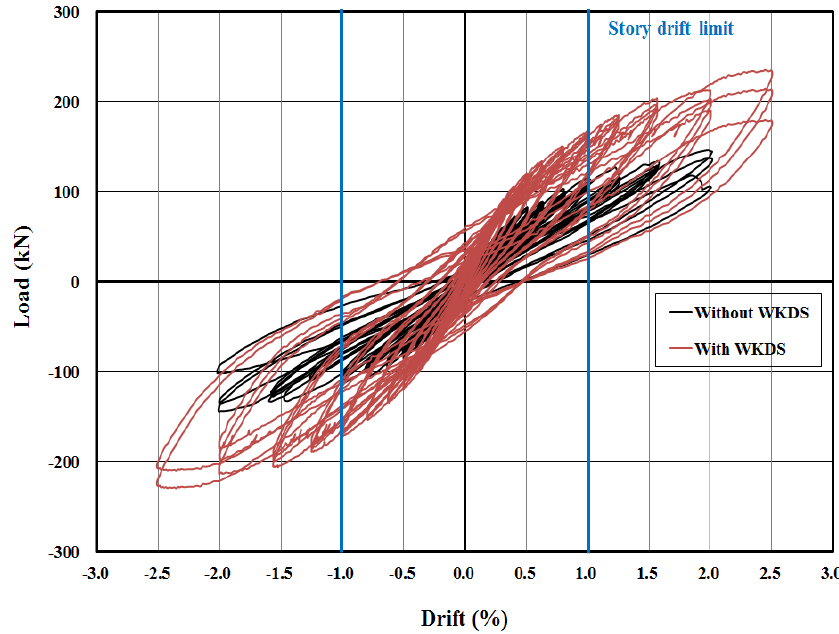
Figure 12. Hysteretic curves of the RC frames with and without the WKDS. Table 3. Yields and maximum loads and displacements of the RC frames with and without the WKDS.